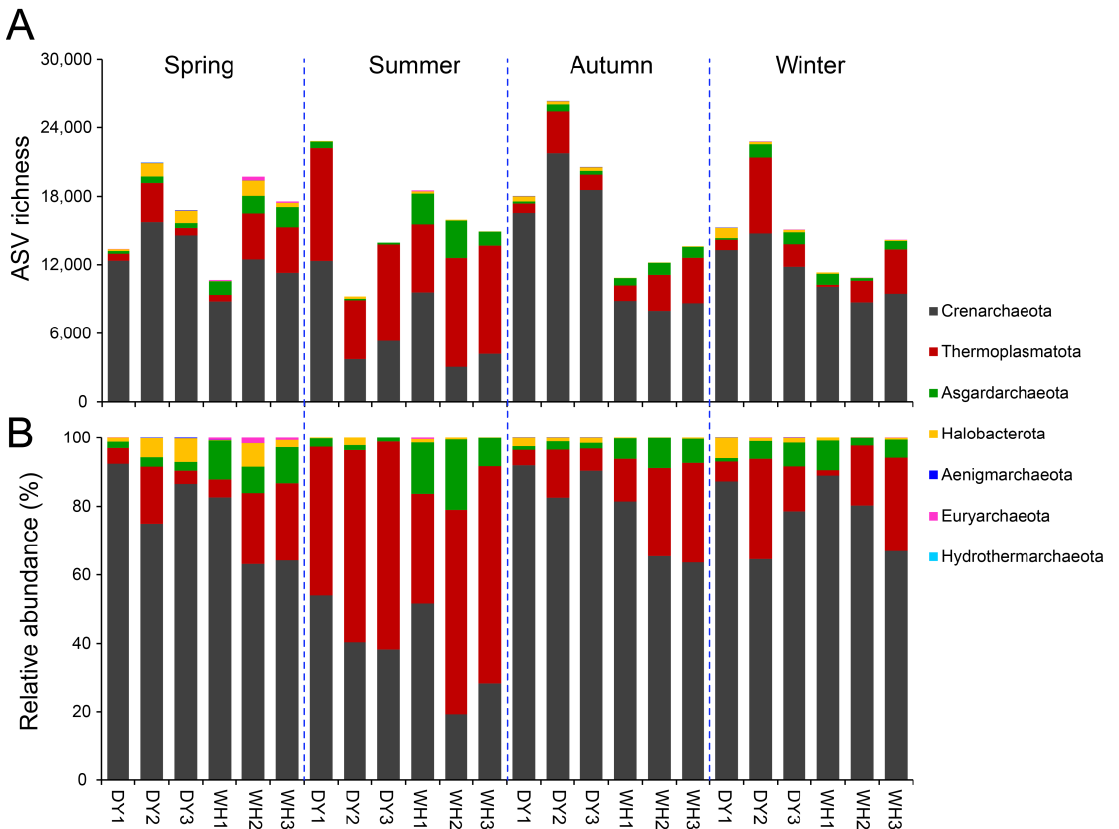
Figure 2. Variations in amplicon sequence variant (ASV) richness and composition of benthic archaeal community in temperate seagrass meadows. Overall ASV number of different phyla in different seasons ( A ). Relative proportions of reads classified at the phylum level across samples collected in four seasons ( B ).